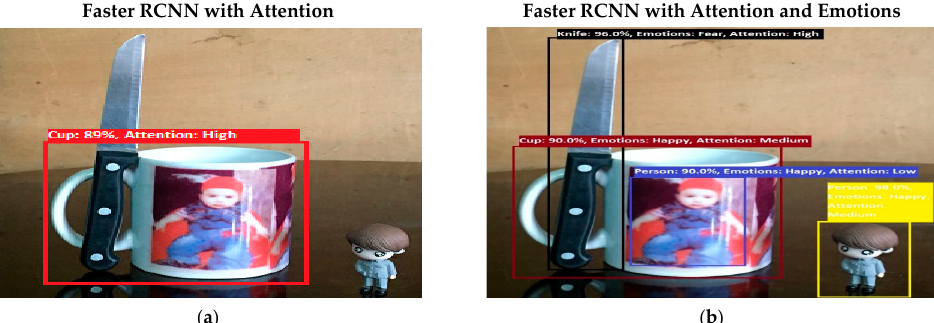
Figure 13. ( a ) In an experiment, the same “Find Cup” query was asked of the system again. Now system finds a cup with more precise recognition. In experiment 9 ( b ), the same “Find Cup” query was asked of the system again. Now system finds a cup with more precise recognition, but still the fear emotion forces the system to generate more attention toward the knife.